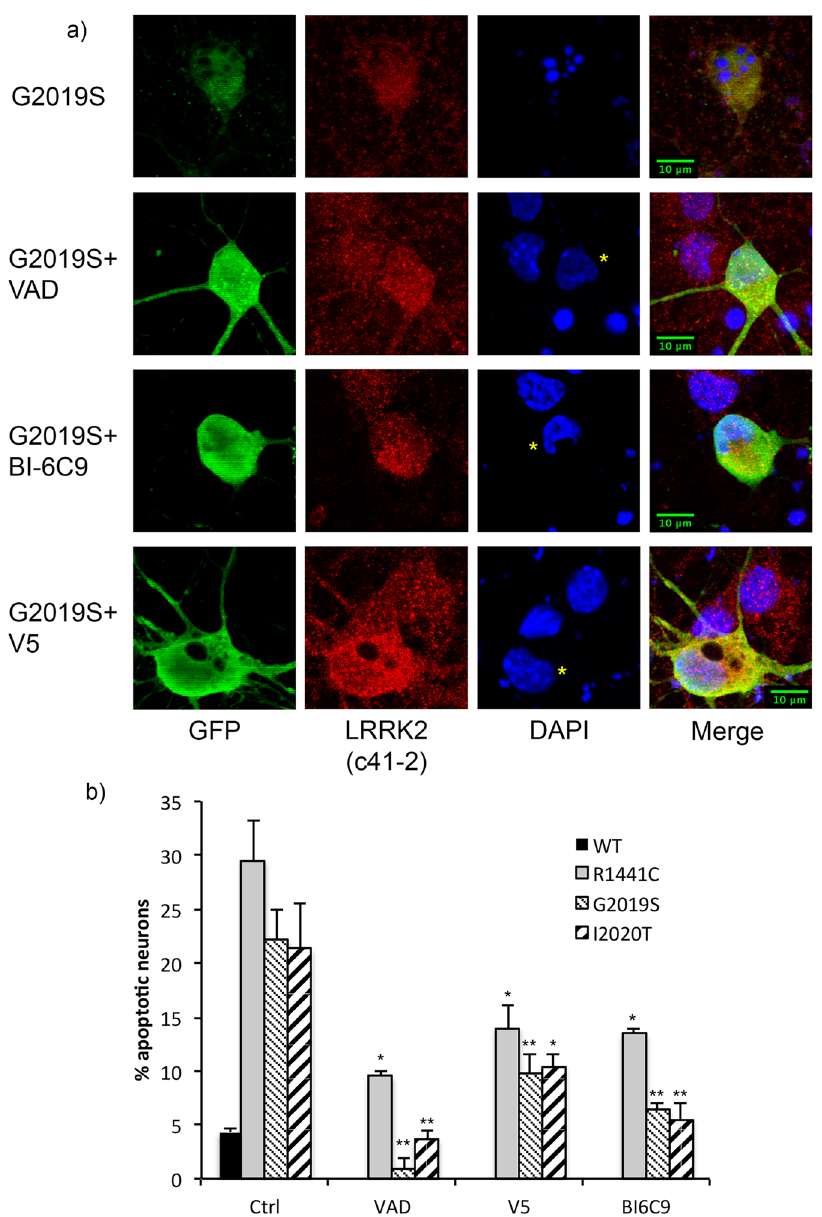
Figure 2. Pharmacological inhibition of Bax and Bid block apoptotic death induced by mutant LRRK2. WT cortical neurons transiently expressing WT, R1441C, G2019S, or I2020T LRRK2 (with an EGFP reporter) were vehicle treated, or treated with a pan caspase inhibitor (VAD), or peptide inhibitors of Bax (V5) or Bid (BI- 6C9). ( a ) A representative confocal image of G2019S mutant LRRK2 expressing neurons, treated with vehicle (DMSO), VAD, V5, or BI-6C9. The percentage of neurons positive for the EGFP reporter and anti-LRRK2 (clone c41–2) exceeded 85%. The stained neurons were counted in a blinded fashion, and the percentage of GFP-positive neurons with apoptotic nuclear features was determined. Inhibition of caspase activation, as well as translocation of Bax or truncated Bid to the mitochondria, protects neurons from apoptotic death induced by different mutant forms of LRRK2. * p < 0.05 compared to untreated R1441C-LRRK2 expressing neurons; ** p < 0.01 compared to untreated G2019S or I2020T-LRRK2 expressing neurons. Each data point represents the mean + / − SEM from 3–4 independent transfections from a representative culture. Cultures were repeated at least 3 times with similar differences. Asterisks indicate LRRK2-expressing